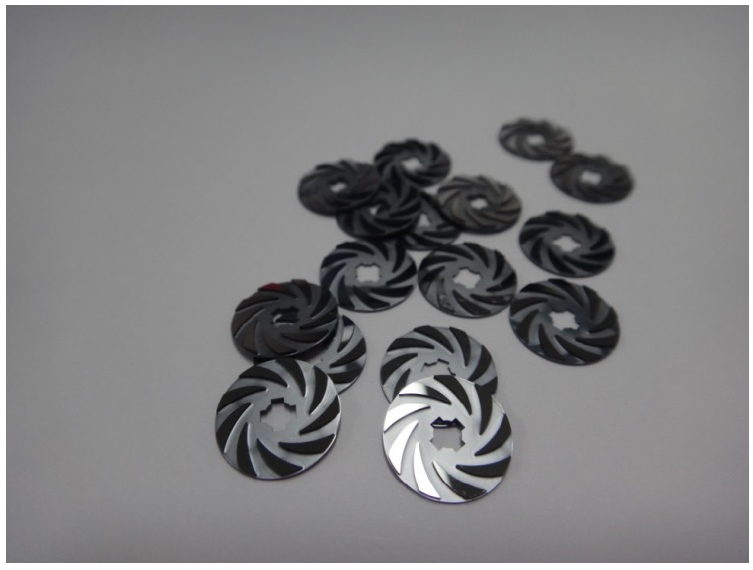
Figure 3. Fabricated MEMS turbine rotor.